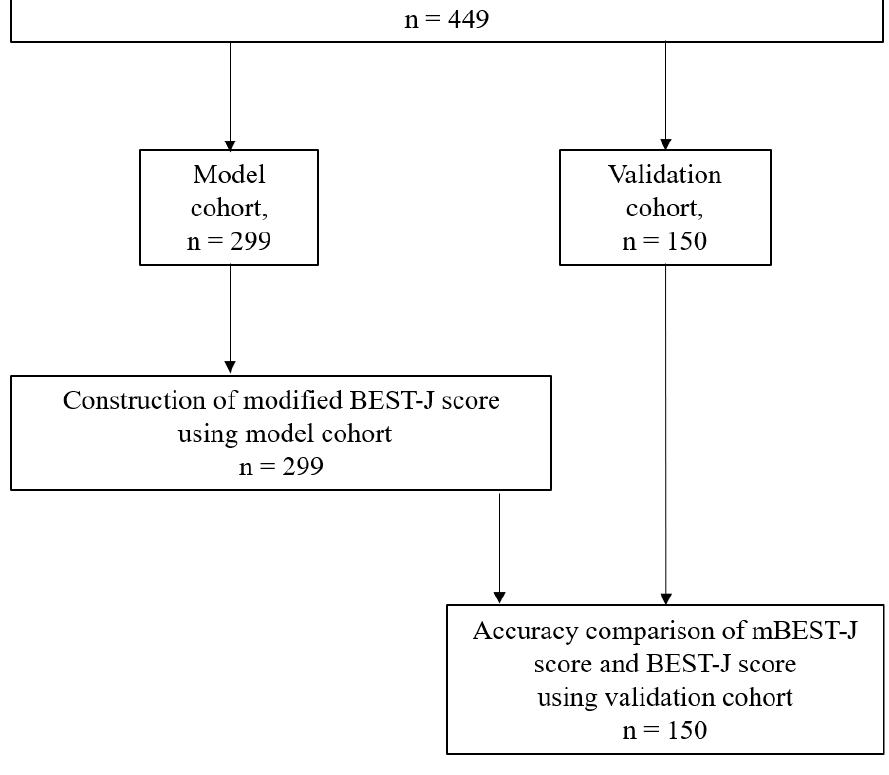
Figure 1. Study design flowchart.